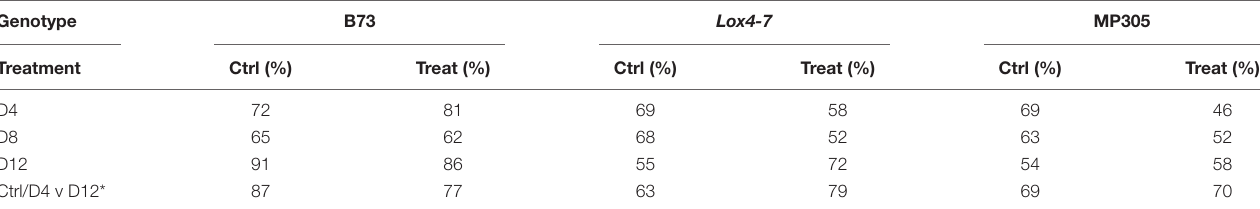
analyzed lesion sizes of four internodes in the field-grown maize at D4, D8, and D12 and changes in intensities of all vibrational bands in the spectra collected from these stalks ( Figure 2 ). We found that lesion size in B73 is correlated with the intensities of three vibrational bands: 986, 1,168, and 1,524 cm − 1 ( Tables 3 , 8 and Figure 5 ). These vibrational bands originate from cellulose Our results also demonstrate that lesion size in lox4-7 is correlated with the intensities of the 1,135 cm − 1 (cellulose) and 1,370 cm − 1 (aliphatic) bands, whereas lesion size in MP305 is correlated with the intensities of the 522 cm − 1 (cellulose),